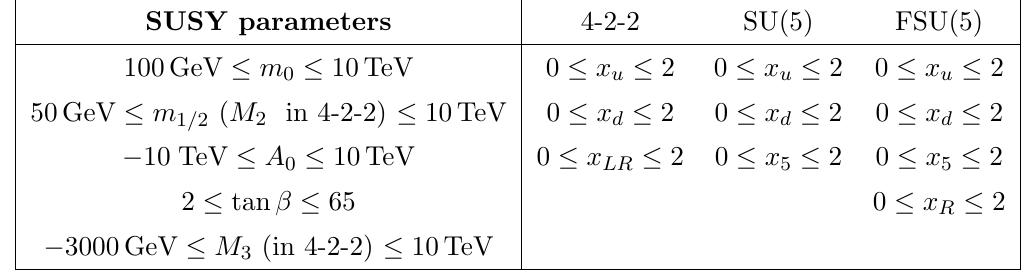
Table 1 . Parameter ranges sampled in our scan of the parameter spaces of the GUT models we